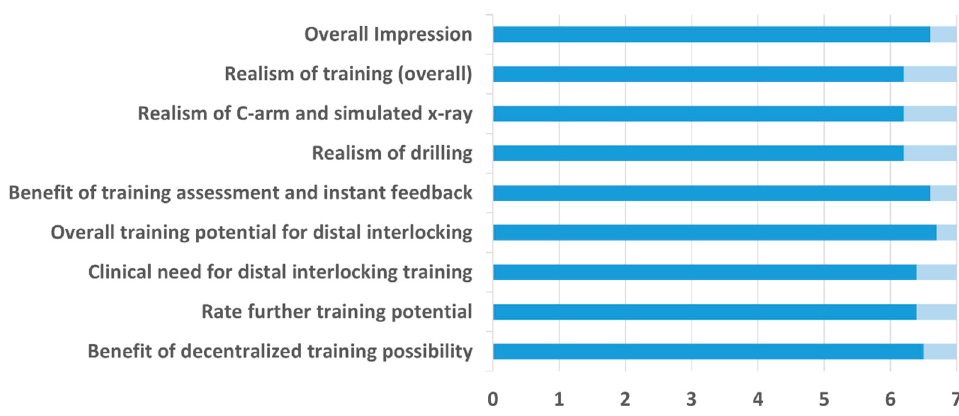
Figure 4. Results from the questionnaire of all participants. 1: “absolute not realistic”; 7 “perfectly realistic”.